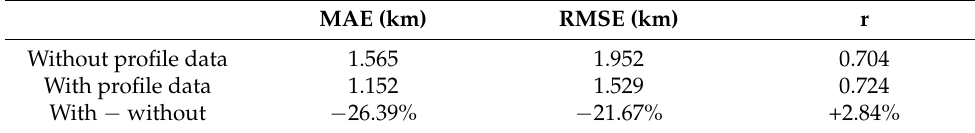
Table 10. Comparison of algorithm results with or without atmospheric profile data.